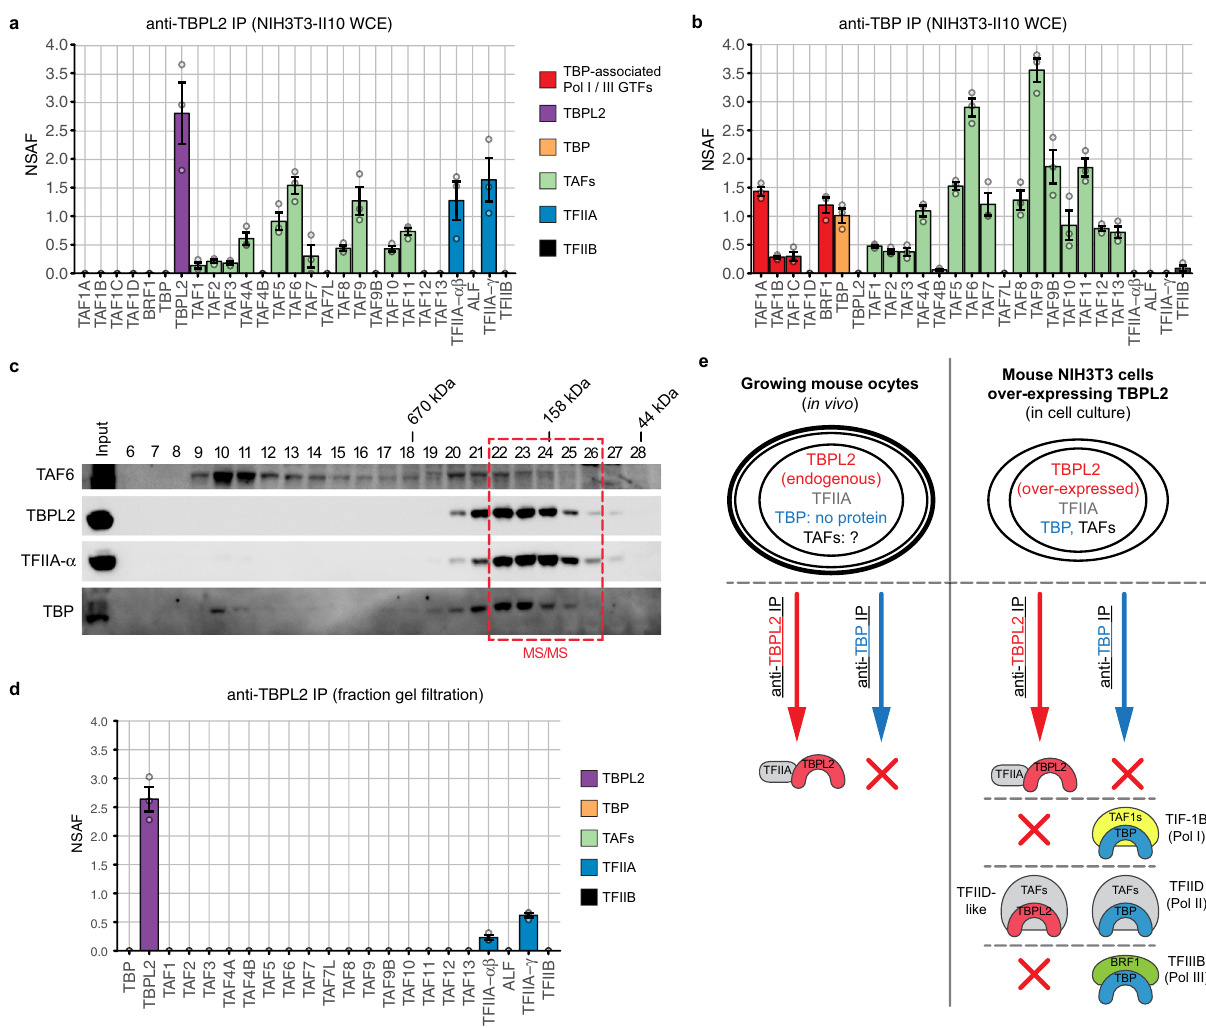
Fig. 2 TBPL2 assembles into a TBPL2/TFIIA and TFIID-like complexes in NIH3T3 cells overexpressing TBPL2. a Anti-TBPL2 immunoprecipitation followed by mass spectrometry (IP-MS) analysis (three technical replicates) of NIH3T3 overexpressing TBPL2 (NIH3T3-II10) whole-cell extracts (WCE). The colour code for the different proteins or complexes is indicated on the right. b Anti-TBP IP-MS analysis (three technical replicates) of NIH3T3-II10 WCE. Colour legend for the different proteins is the same as in ( a ). c Western blot of a Superose 6 gel fi ltration analysis of NIH3T3-II10 WCE probed with anti-TAF6 (top panel), anti-TBPL2 and anti-TFIIA- α (middle panels) and anti-TBP (bottom panel) antibodies. Fraction numbers are shown above each lane, and the elution of known molecular mass markers is indicated above the panels. The pooled fractions used for mass spectrometry analysis are indicated in red. d Anti-TBPL2 IP-MS analysis (three technical replicates) of the gel fi ltration fraction indicated in ( c ). The colour code for the different proteins or complexes is indicated on the right. NSAF normalised spectral abundance factor. e Schematic representation of the fundamental differences existing between TBPL2- and TBP-containing complexes in growing oocytes and NIH3T3-II10 cells. In ( a , b , and d ) grey dots indicate replicates and error bars, + / − standard error of the